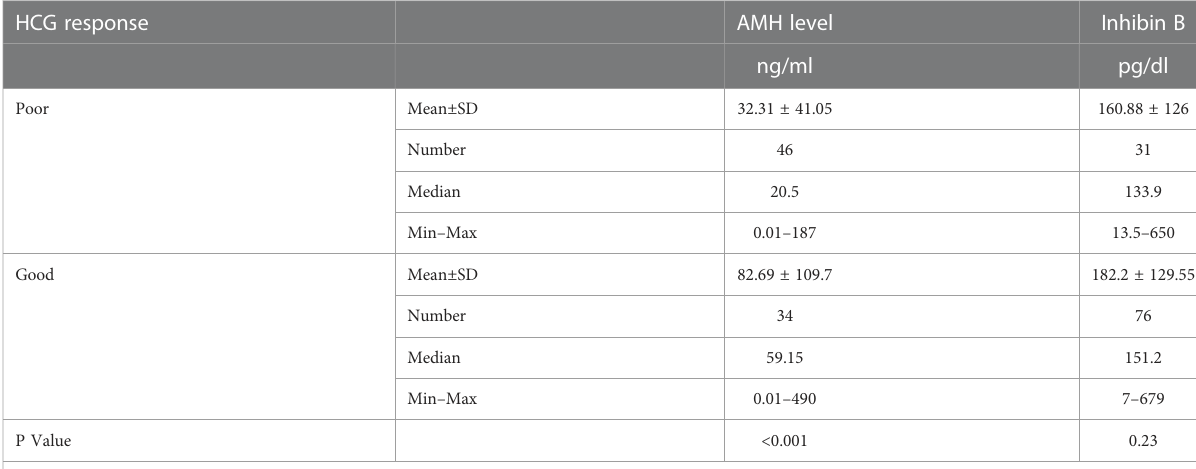
TABLE 4 Comparison between patients with suf fi cient and inadequate HCG response with respect to AMH and Inhibin B levels. HCG